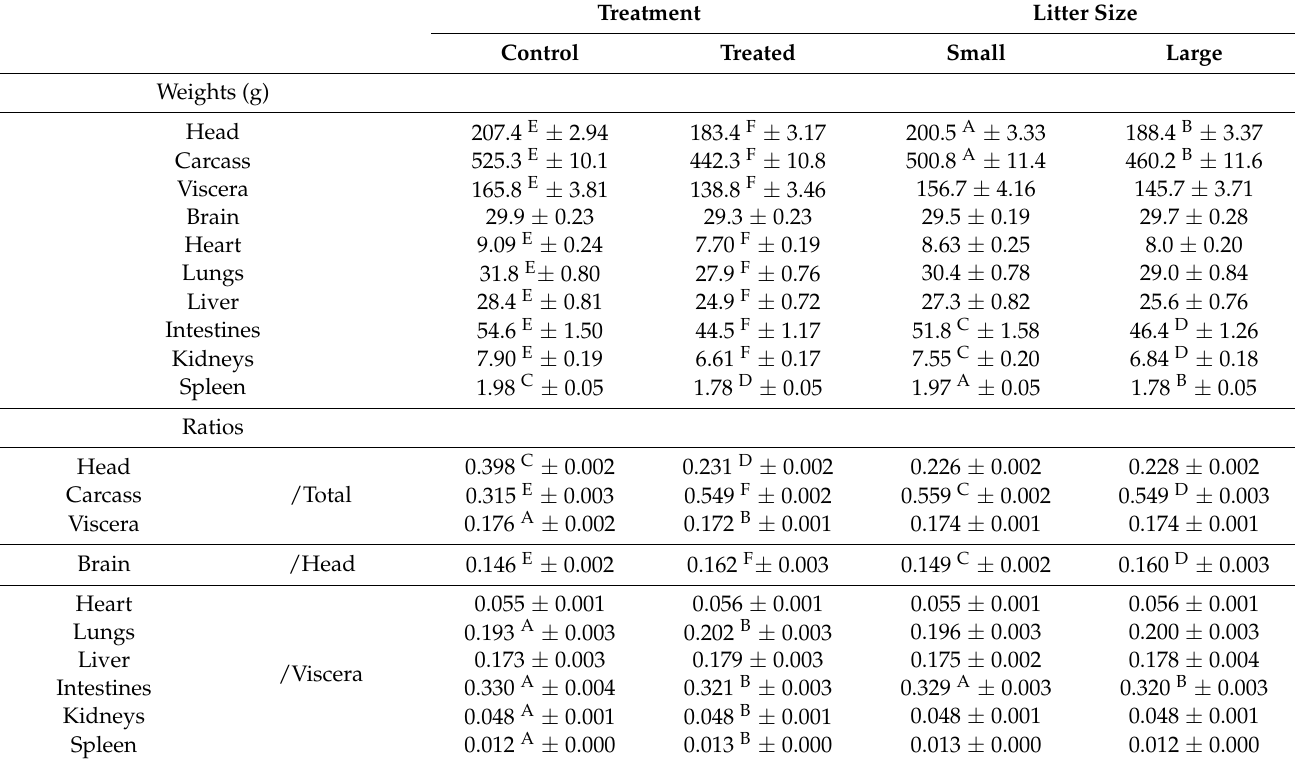
Table 2. Mean ( ± S.E.M.) values of weight of different body parts and major organs and their ratios at Day 100 of gestation in different treatments (fetuses from control sows, Group C and from sows treated with hydroxytyrosol, and n-3-PUFA from Day 35 to Day 100 of gestation (Group T) and by litter sizes (small ≤ 9 fetuses, large > 9 fetuses).